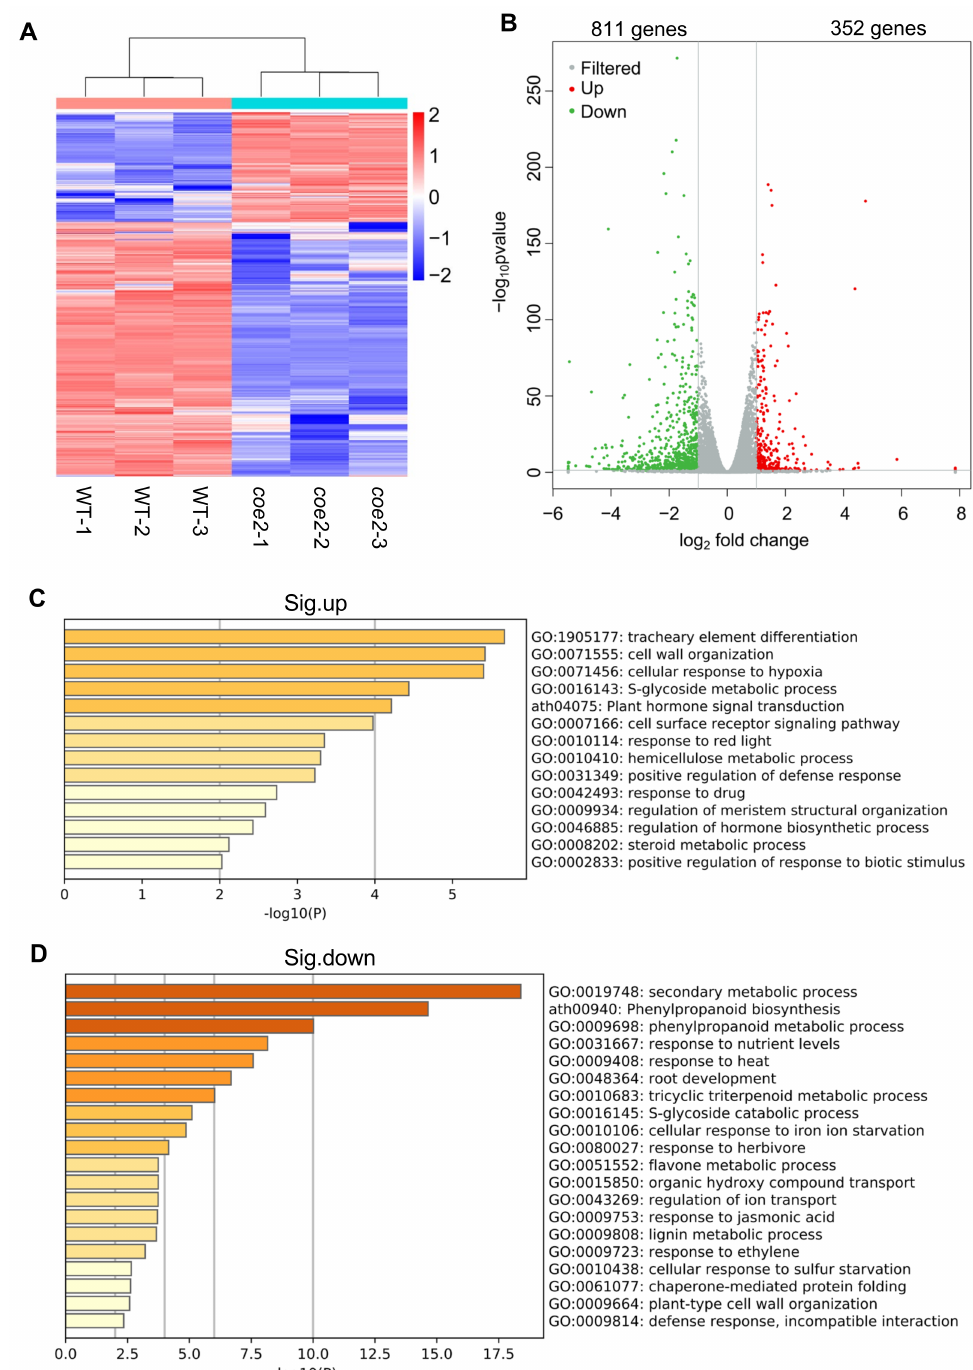
Figure 4. Analysis of the differentially expressed genes (DEGs) in cotyledons of coe2 and WT. ( A ) Heatmap displays the expression pattern of the DEGs in cotyledons of coe2 and WT. ( B ) Volcano plot shows the distribution of the DEGs in cotyledons of coe2 and WT. Gene Ontology (GO) analysis of the up-regulated DEGs ( C ) and significantly down-regulated DEGs ( D ) in cotyledons of coe2 , compared with